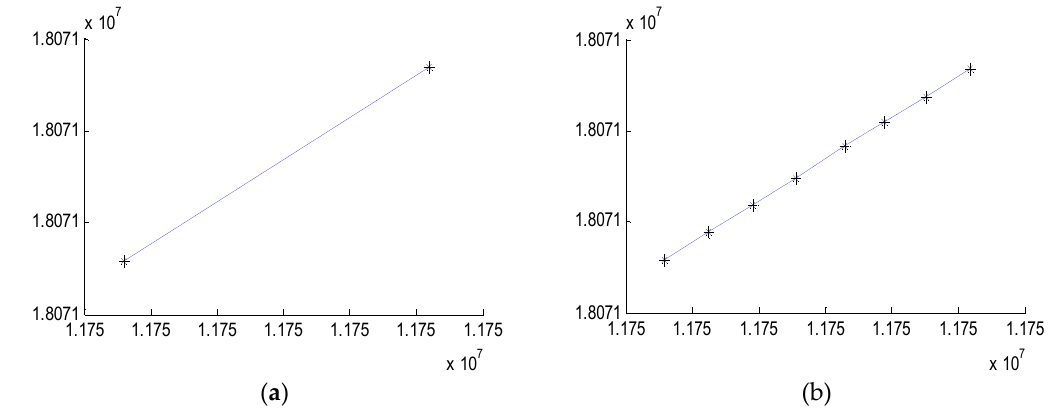
Figure 8. The coordinate of lane lanes in UTM. ( a ) full lane line; ( b ) dotted lane line.